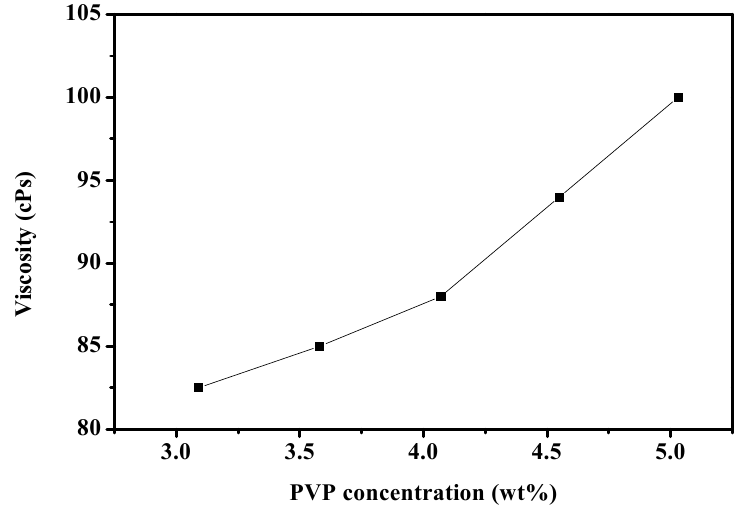
Materials 2015 , 8 4